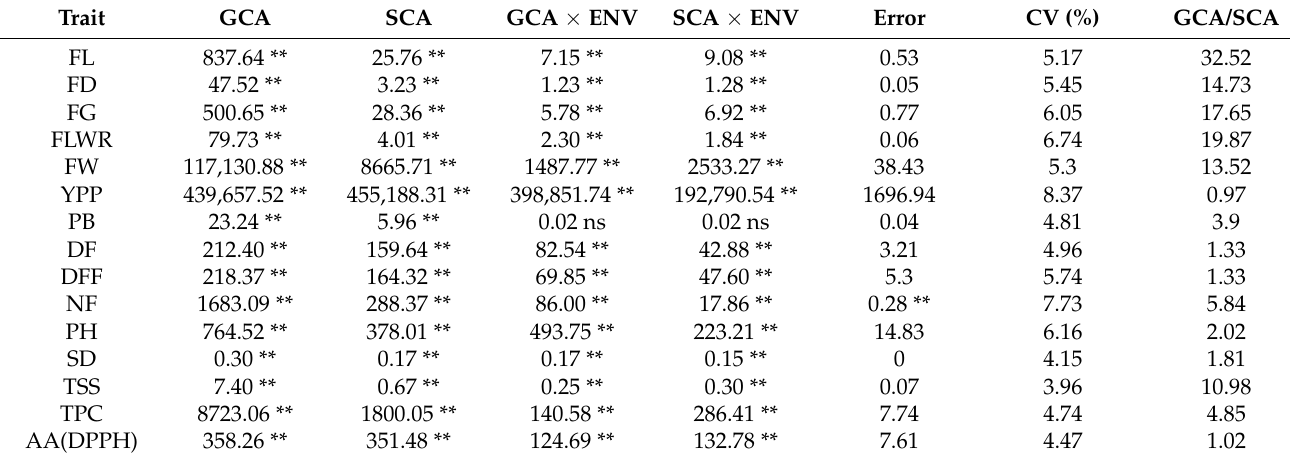
Table 4. Mean squares of Analysis of variance for combining ability of the studied traits in pooled environments. Trait GCA